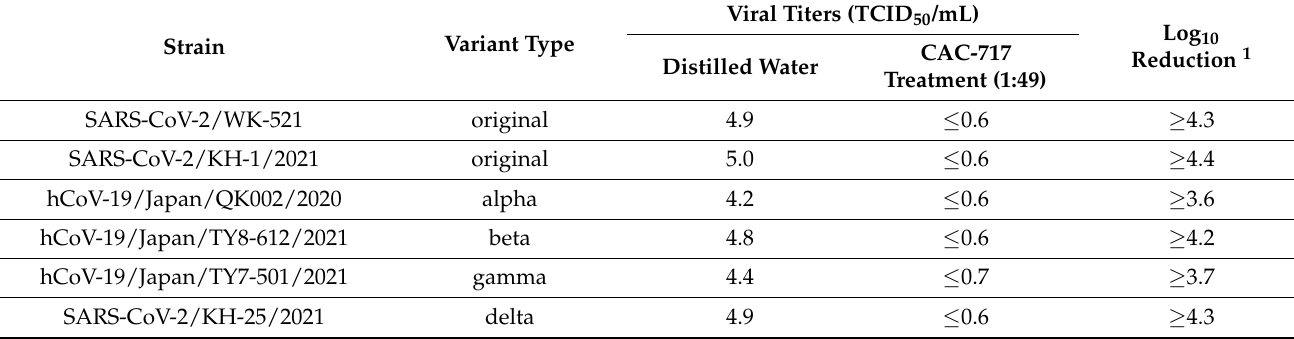
Table 2. Virucidal efficacy of CAC-717 against SARS-CoV-2